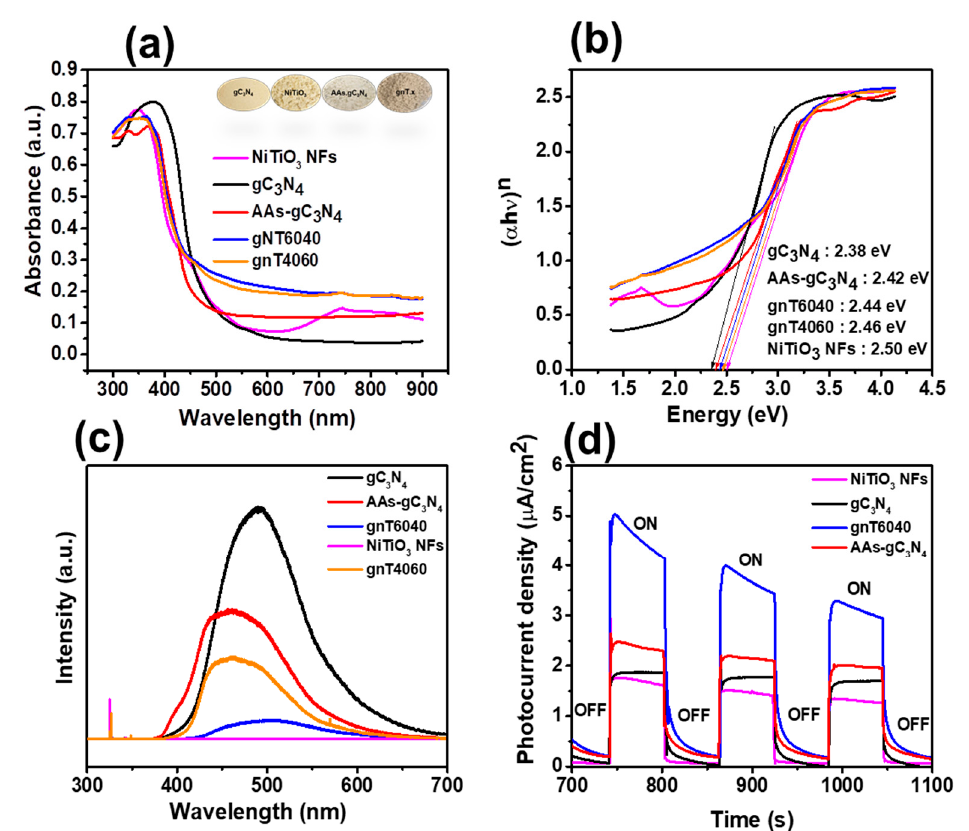
Figure 6. ( a ) Absorbance, ( b ) bandgap energy, ( c ) photoluminescence, and ( d ) transient photocurrent density of NiTiO 3 NFs, gC 3 N 4 , AAs-gC 3 N 4 , and gnT6040 hybrid photocatalyst.